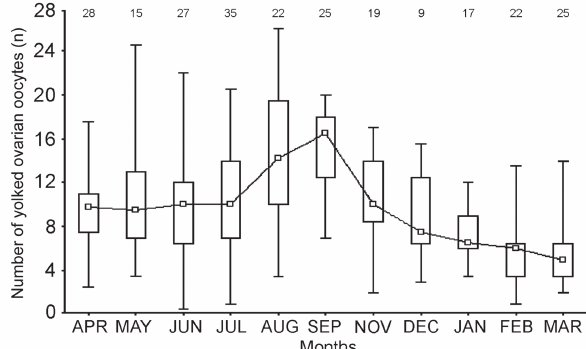
Fig. 9. Monthly variation of the mean number of yolked ovarian oocytes (NYO) of mature females of Sympterygia bonapartii from San Matías Gulf (Argentina). Boxes indicate the percentiles 25-75%; the inner square indicates the median value and bars the range of data distribution. Individuals sampled during September and October were analyzed together. The number of samples is given in